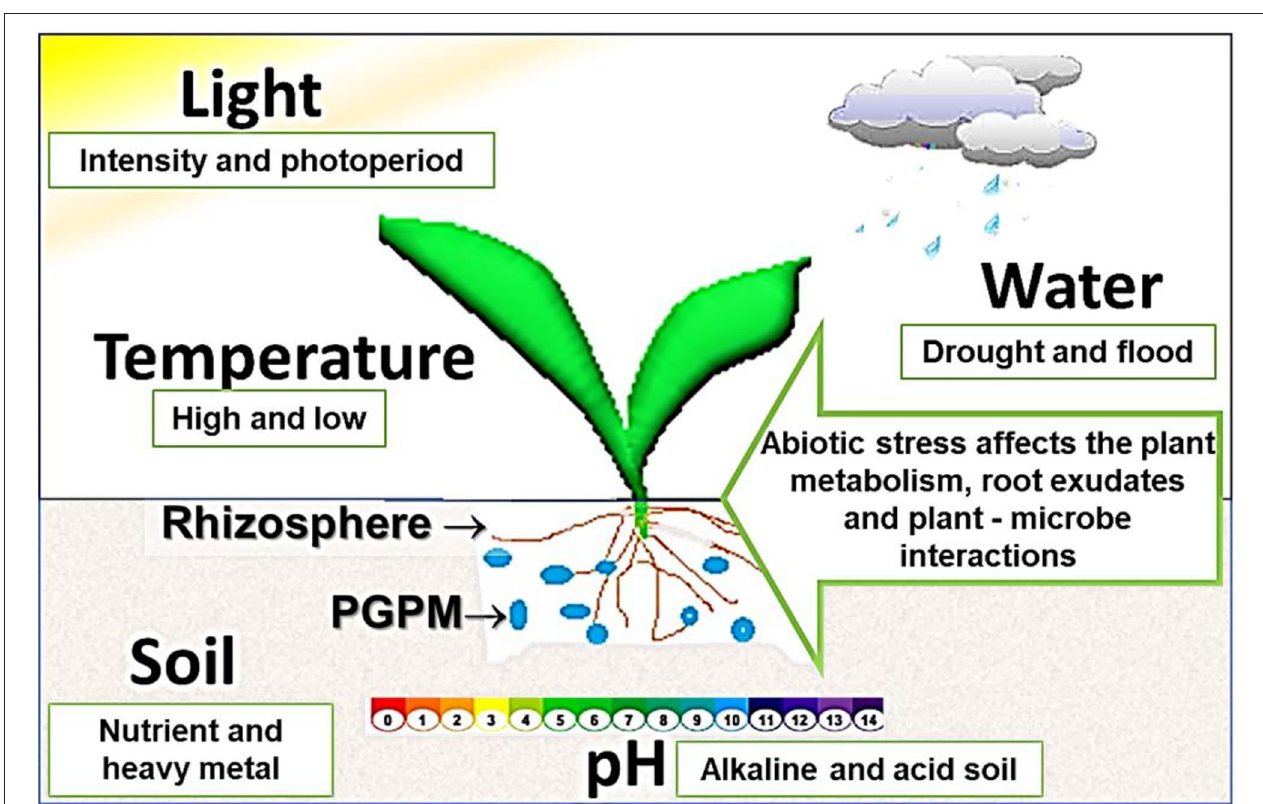
FIGURE 3 | Abiotic factors can cause stresses that impacts the plant metabolism, modifying root exudates compositions. This can affect the rhizosphere microbiome and plant-microbe interactions and, consequently, impair the potential benefit of plant growth-promoting microbes (PGPM) to host